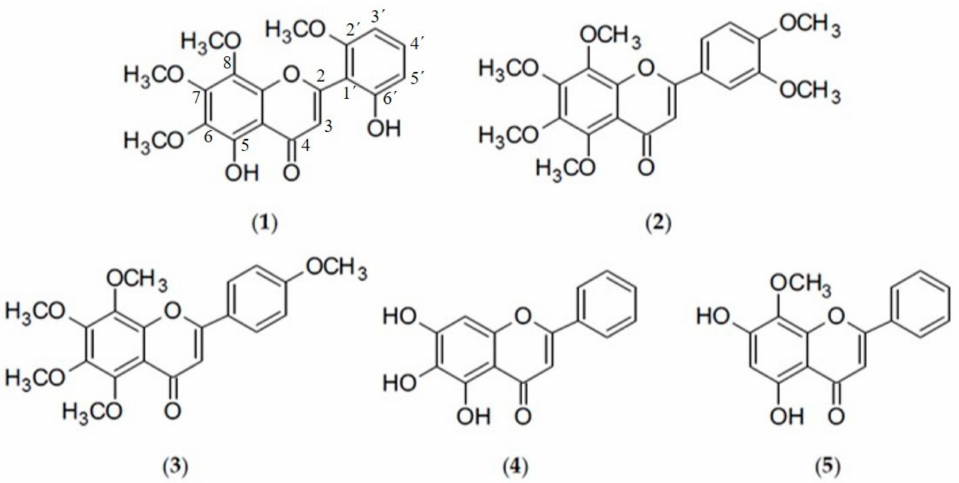
Figure 1. Chemical structures of skullcapflavone II ( 1 ), nobiletin ( 2 ), tangeretin ( 3 ), baicalein ( 4 ), and wogonin ( 5 ).